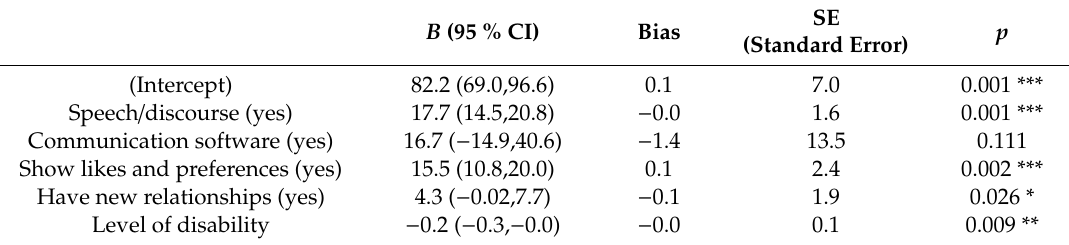
Table 7. Bootstrapped robust multiple regression coe ffi cients (whole